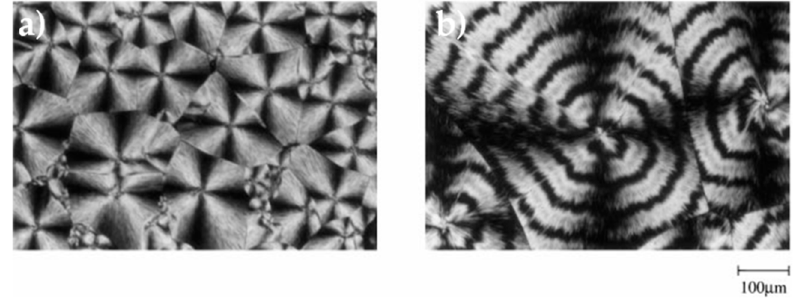
Figure 3. Optical micrographs of PLA spherulites in: ( a ) neat PLA; and ( b ) PLA-PHB (75:25) blend crystallized at 130 °C from the melt (200 °C). Reprinted with permission from [54].